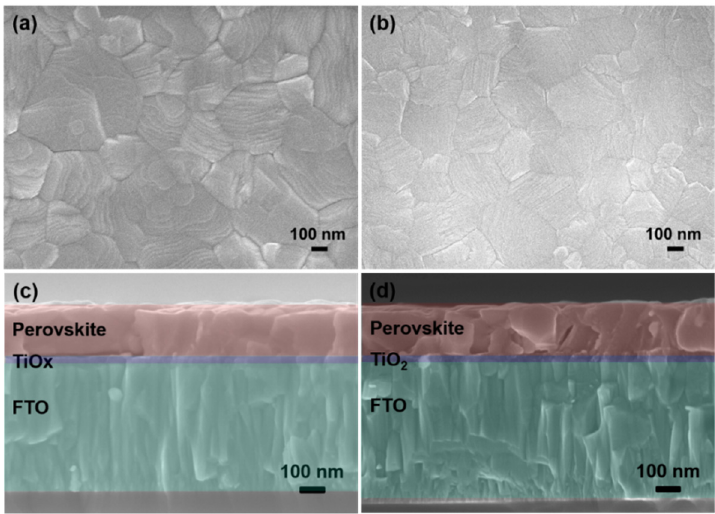
Figure 3. Top-view SEM images of the ( a ) TiO x /MAPbI3 film and ( b ) TiO 2 /MAPbI 3 film, and cross-sectional SEM images of the ( c ) FTO/TiO x /MAPbI 3 film and ( d ) FTO/TiO 2 /MAPbI 3 film.